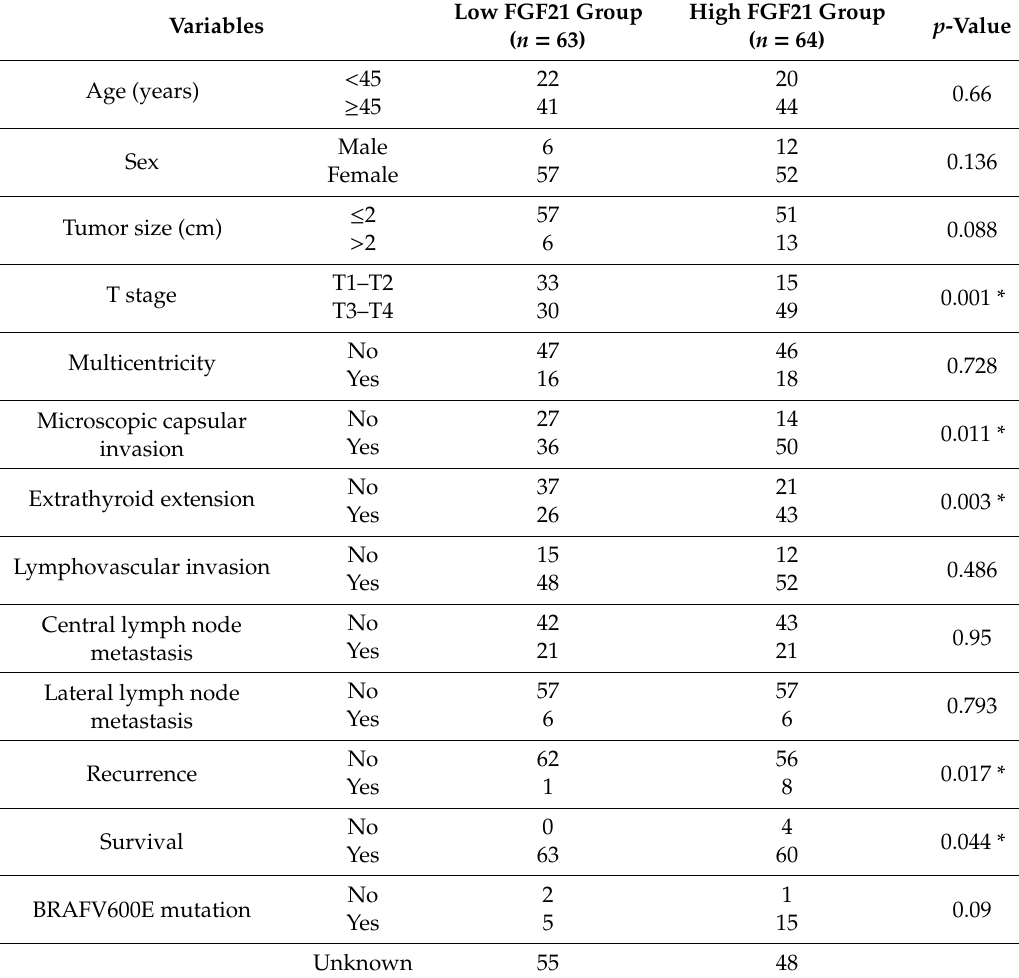
Table 2. Clinicopathological parameters of 127 patients according to serum level of